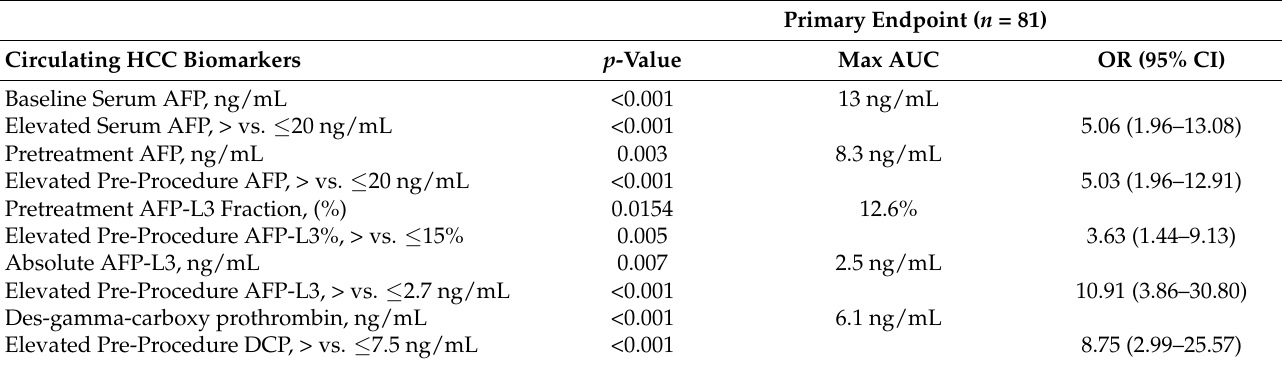
Table 3. Univariate Analysis of AFP, AFP-L3%, and DCP with Bridge to Transplant Outcome of HCC Progression after Liver-Directed